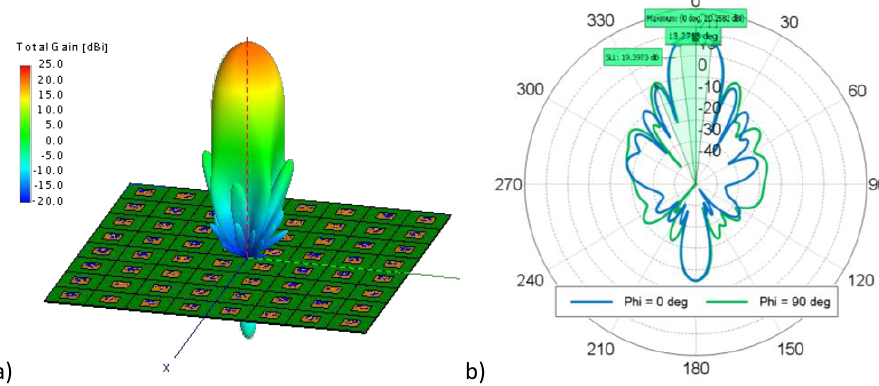
Fig. 6. The antenna array 3D (a) and polar (b) radiation